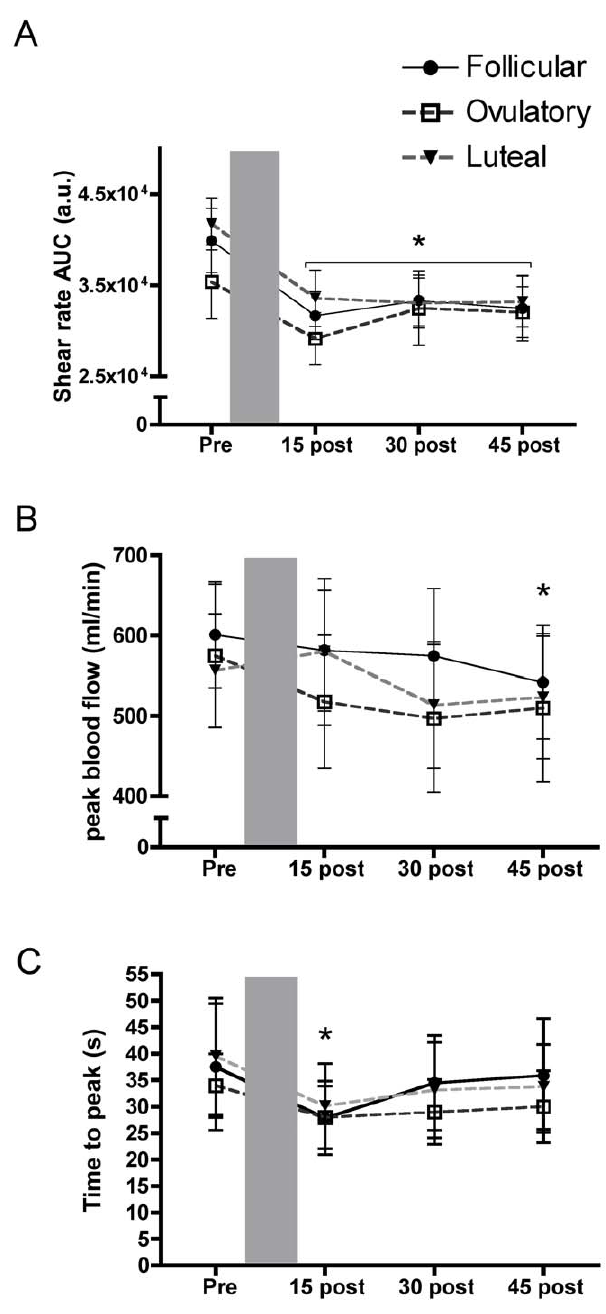
Figure 3. Shear rate responses after cuff deflation. a) 60s brachial artery reactive hypaeremic shear rate area under the curve (AUC) were reduced throughout the recovery period compared with measures taken prior to the prolonged low flow (PLF) (shaded area). b) Peak reactive hyperaemic blood flow was unaltered by PLF whereas c) time to peak dilation was reduced at 15 minutes of recovery but recovered by 30 minutes. There were no significant differences within the menstrual cycle. * Indicates a significant difference ( p # 0.05) from PRE PLF (main effect for Time) determined by post hoc analysis. AUC is the area under the